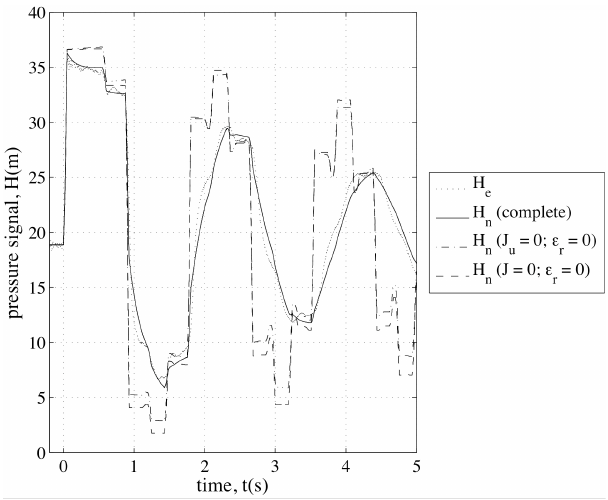
Figure 9. Determination coefficient of the different numerical models in the case of a damaged pipe, with the leak no. 1 (dark grey) and no. 2 (light gray).